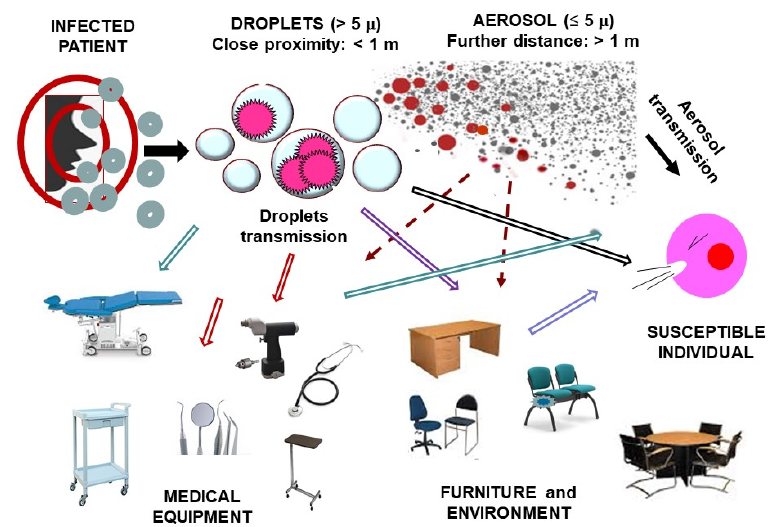
Figure 1. Routes of transmission in outpatient practice (adapted from Ge et al. [15]).